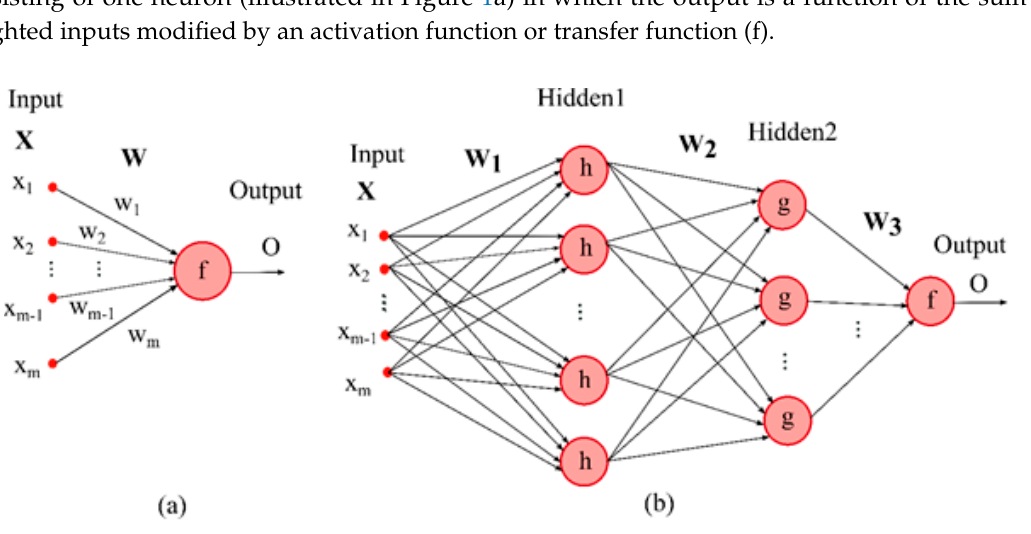
Figure 1. ( a ) Perceptron model, ( b ) Multilayer perceptron (MLP) with two hidden layers (Note that f, g, and h are activation functions, while the w represents the weights that the model needs to learn. x is also input of the